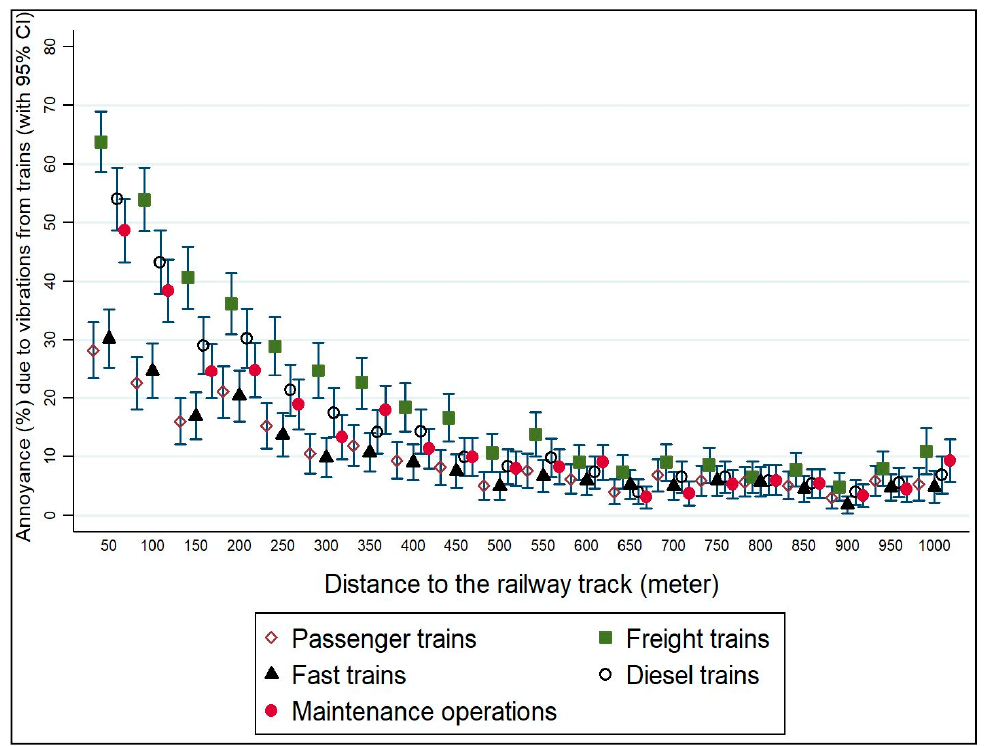
Figure 2. The association between distance from the railway track and annoyance due to vibrations from trains.